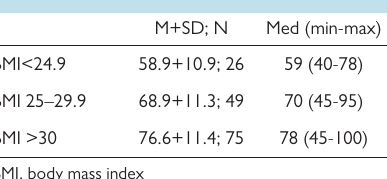
Table 3. Stiffness of the ligamentum flavum Table 5. Relation between BMI and distance Table 6. Post-hoc dual comparison